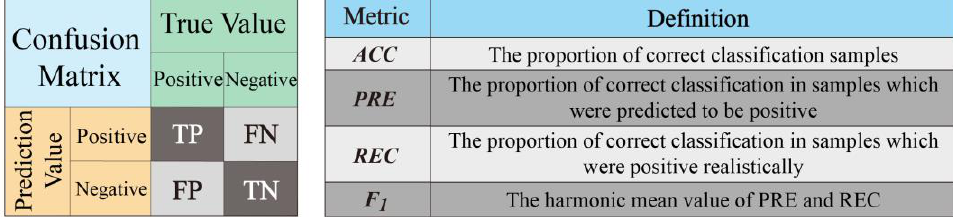
Figure 10. Schematic of the confusion matrix.